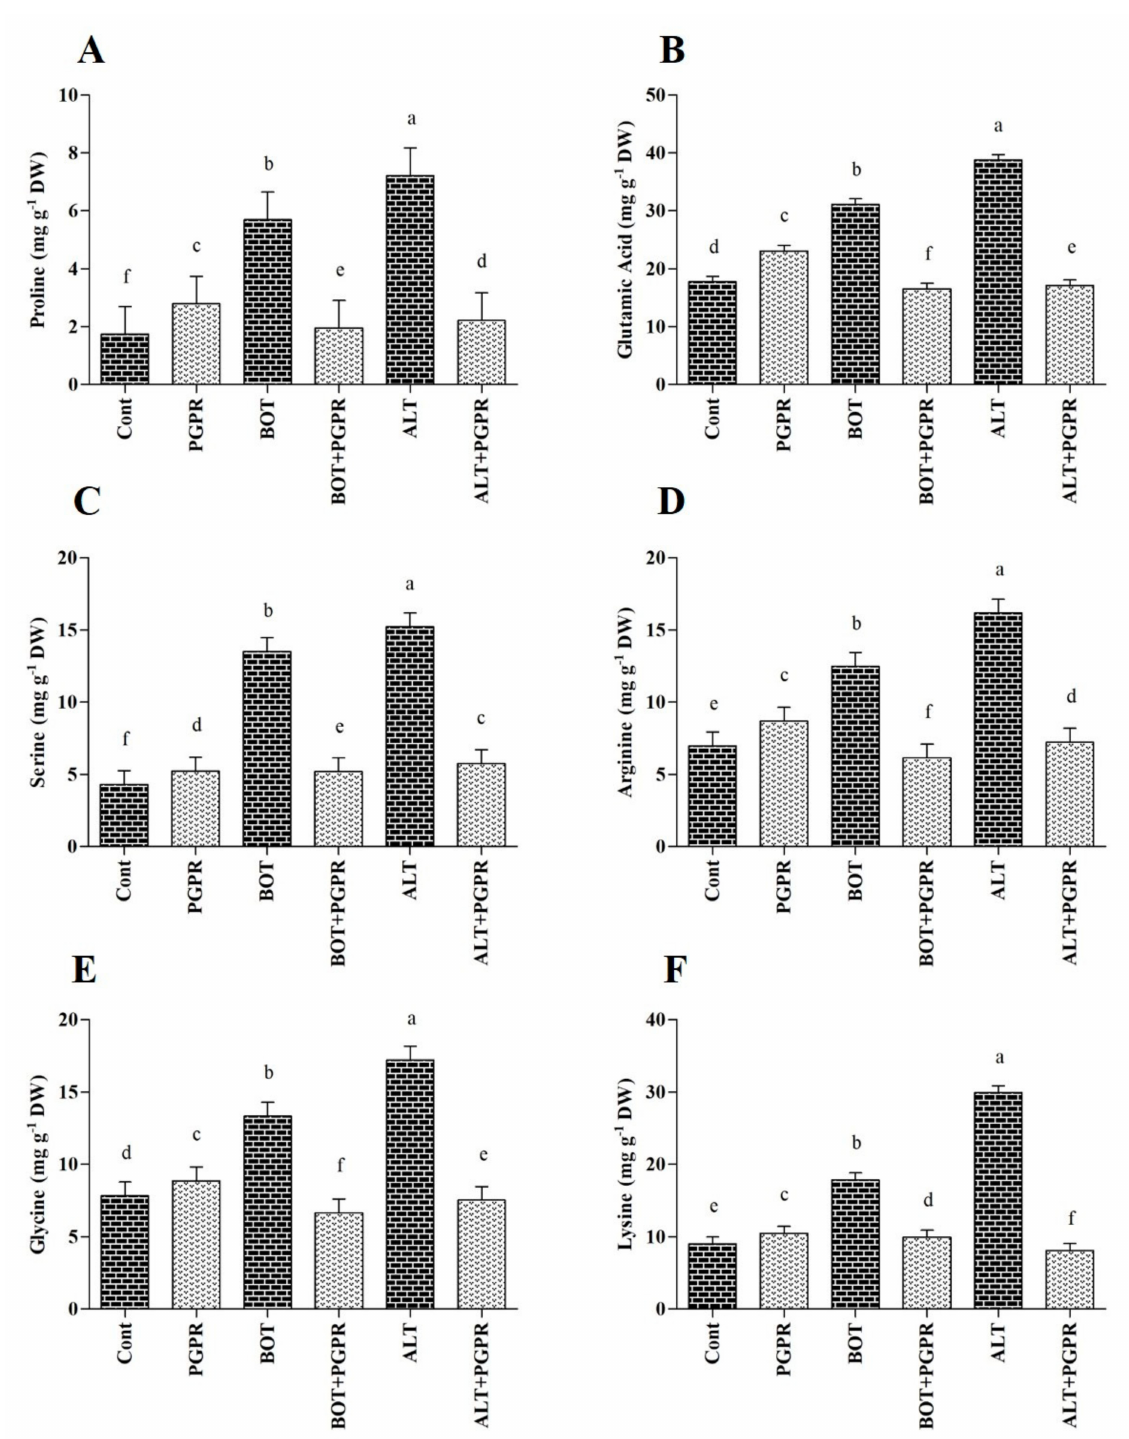
Figure 6. Amino acid contents (( A ) Proline; ( B ) Glutamic acid; ( C ) Serine; ( D ) Arginine; ( E ) Glycine; ( F ) Lysine) in the leaves of peppers grown under normal and stress conditions and treated with plant growth-promoting rhizobacteria (PGPR) after eight days. Treatment: Cont (control), PGPR ( Bacillus amyloliquefaciens ), BOT ( Botrytis pelargonii ), PGPR + BOT ( Bacillus amyloliquefaciens + Botrytis pelargonii ), ALT ( Alternaria alternata ), PGPR + ALT ( Bacillus amyloliquefaciens + Alternaria alternata ). Values show the means ± standard error ( n = 3) and significant differences are indicated at p < 0.05 in accordance with the least significant difference test. Bars with different letters are significantly different from each